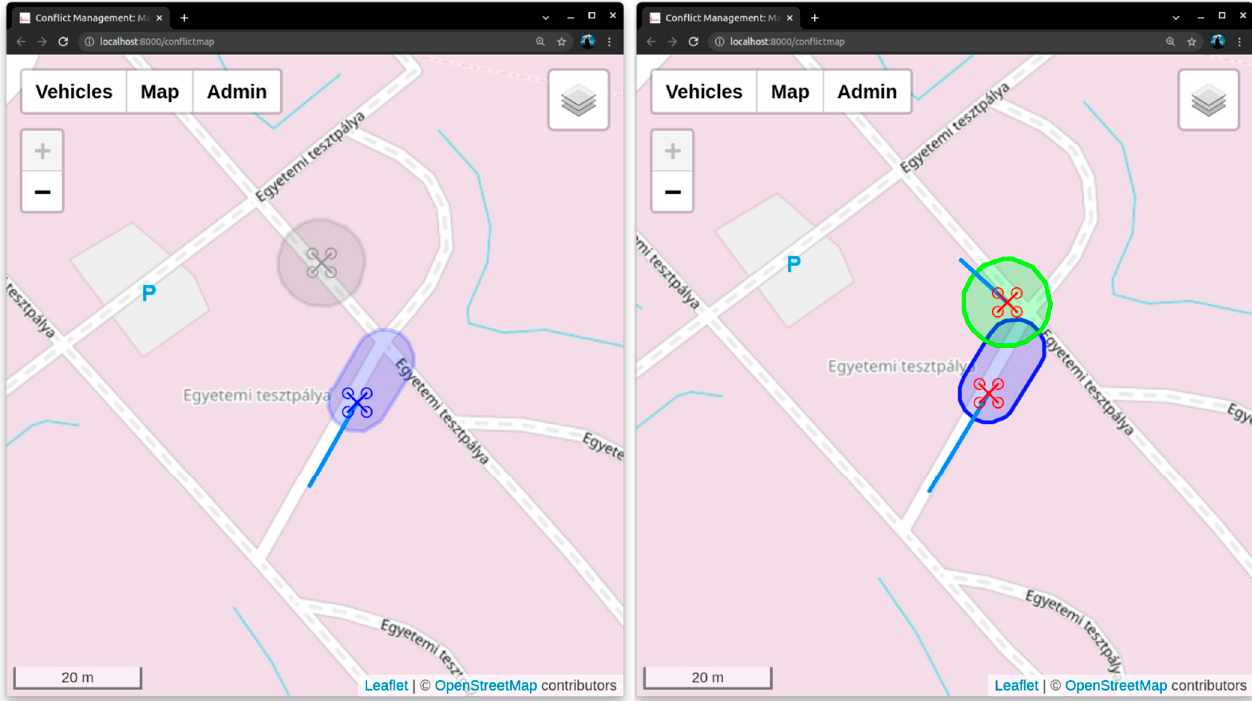
Figure 9. Version 2 GUI: indication of timed out telemetry ( left ), conflict area marked as active ( right ). Non-English text are road and area designations.